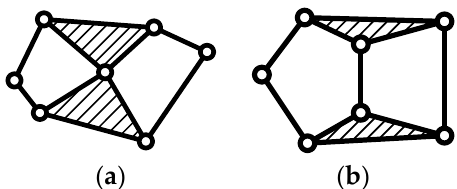
Figure 2. Kinematical chain of the closed-chain six-bar mechanism with a single degree of freedom (DOF). ( a ) Watt type. ( b ) Stephenson type.